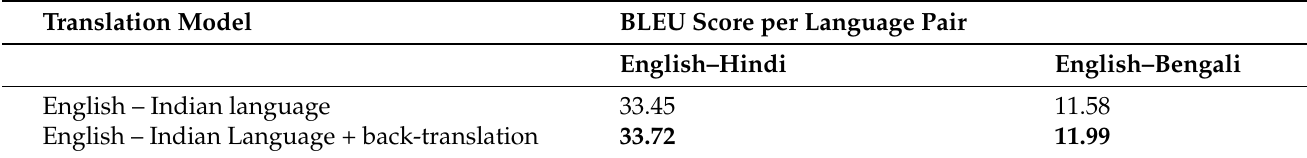
Table 2. BLEU scores for English-to-Indian language translation models on Samanantar dataset. Translation Model